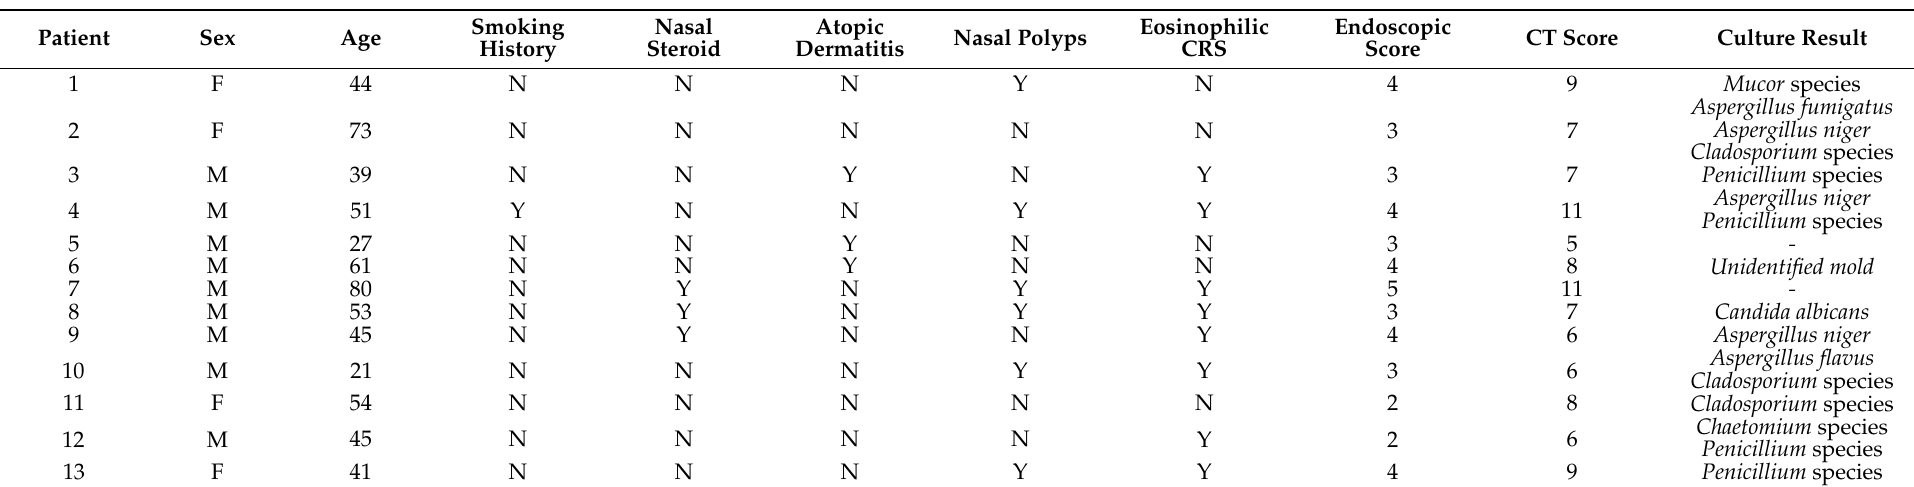
Table 1. Demographic data of chronic rhinosinusitis patients.